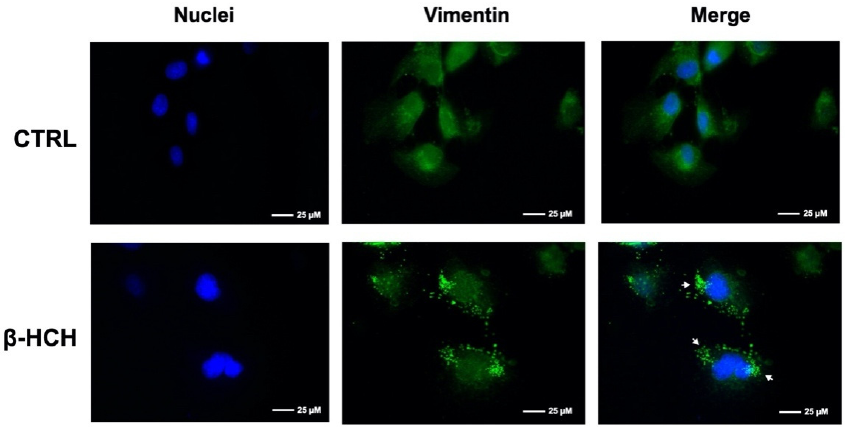
Figure 10. β -HCH induces a rearrangement in vimentin organization. Cells were exposed to 10 µM β -HCH for 48 h and subjected to immunofluorescence analysis using a specific antibody against vimentin. White arrows indicate the punctu- vimentin. White arrows indicate the punctuated pattern assumed by vimentin in treated cells, ated pattern assumed by vimentin in treated cells, testifying to a morphological change. The selected images are repre- testifying to a morphological change. The selected images are representative of three independent sentative of three independent experiments and were captured under the same acquisition parameters. experiments and were captured under the same acquisition